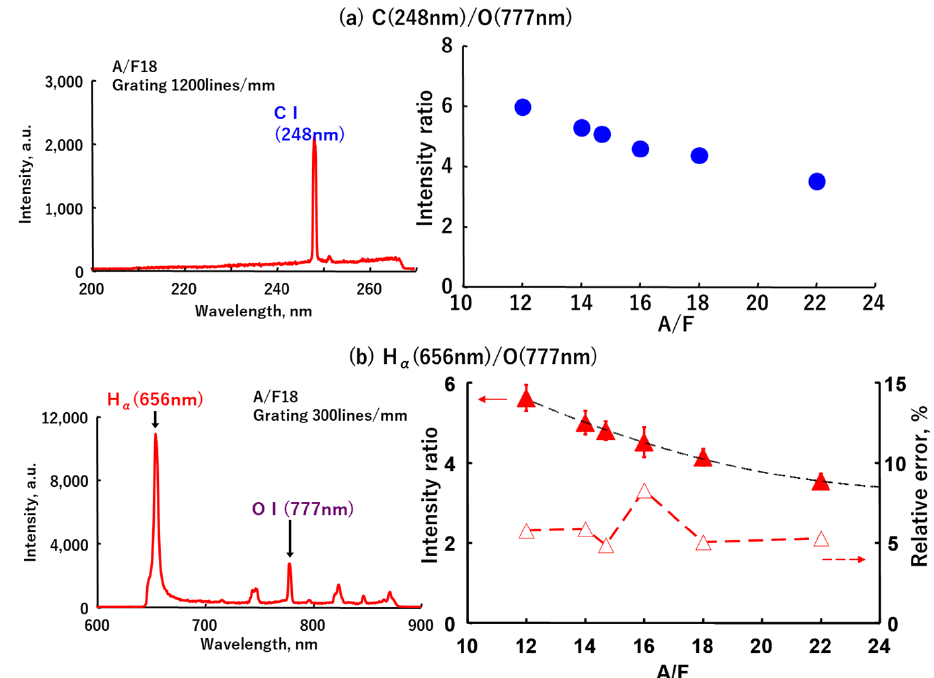
Figure 13. Relationship between intensity ratio and A/F: ( a ) C/O atomic spectrum intensity ratio and ( b ) H/O atomic spectrum intensity ratio. Both C/O and H/O has good correlation with A/F.